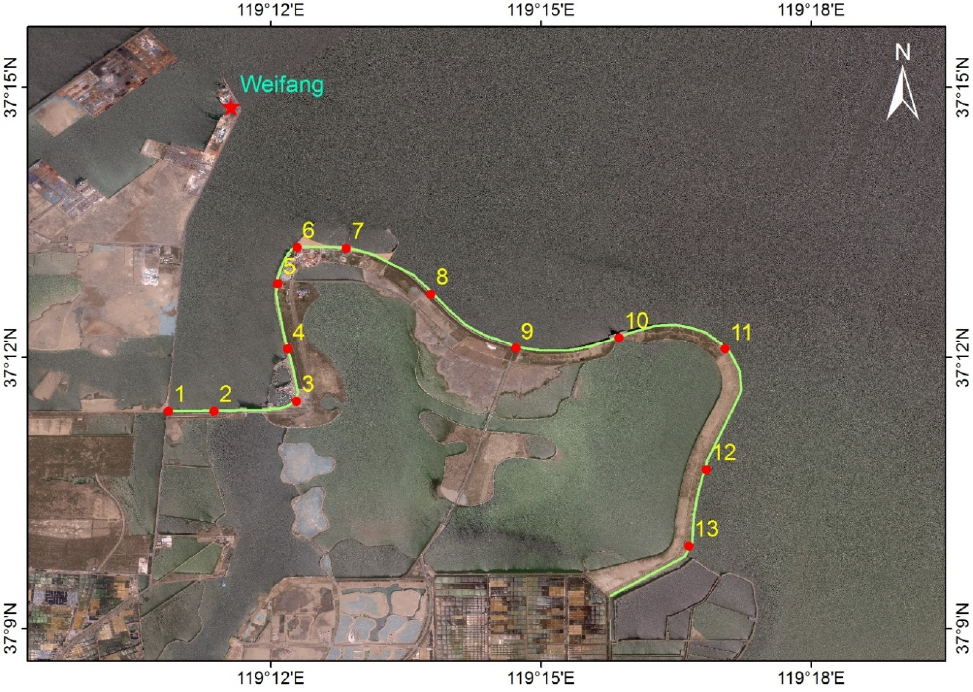
Figure 1. Weifang levee from above. The green line indicates the position of the levee. The red dots indicate the 13 measuring points. The red star in the upper-left corner indicates the position of the Weifang tidal gauge station.